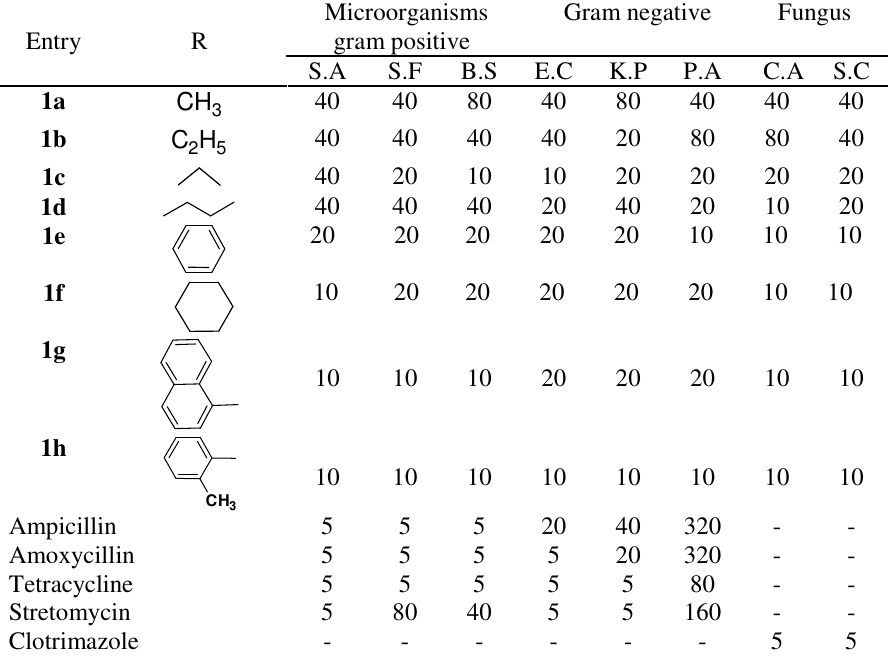
Table 2 . Antimicrobial activity results (MIC, µ g/mL) of the newly synthesized compounds with the standard